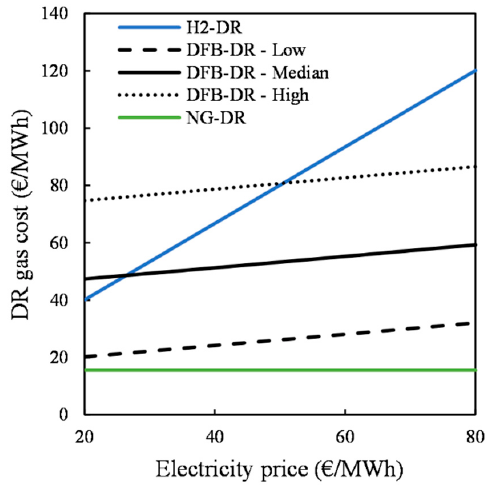
Figure 6. Costs for the reducing gas sent to the DR reactor for the three DR routes. For the DFB-DR route, the “Low” series is based on a biomass price of 0 EUR/MWh and the lower boundary of the CAPEX of the DFB loop and the gas-handling section, whereas the “High” series is based on a biomass price of 40 EUR/MWh and the upper boundary of the CAPEX.